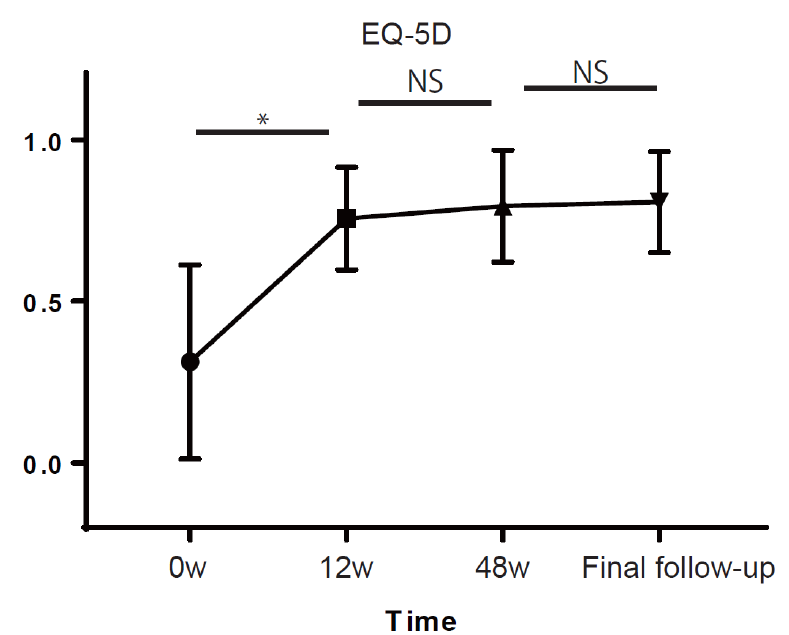
Figure 1. Temporal trends in outcome measures. The visual analog scale (VAS) for low back pain (0–10, with higher scores indicating severe pain) and the European Quality of Life-5 Dimensions Questionnaire (EQ-5D, − 0.111 to 1, with higher scores indicating better quality of life). Means with standard deviations at baseline and each follow-up are shown. * p < 0.05, NS not significant.